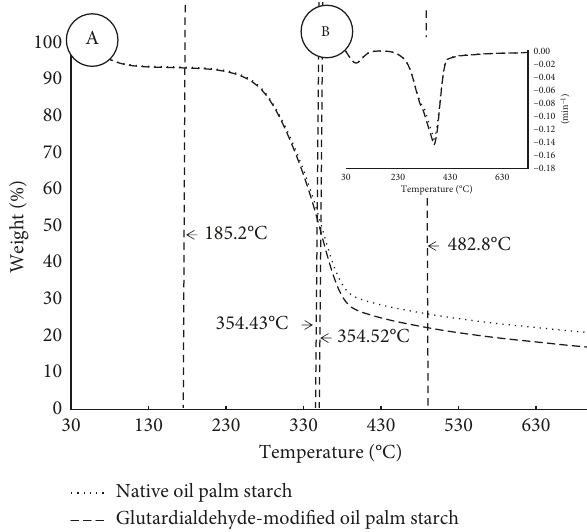
Figure 4: Thermal gravimetric analysis (A) and derivative thermal gravimetric analysis (B) curve for OPS wood composite powder and OPSMG wood composite powder.